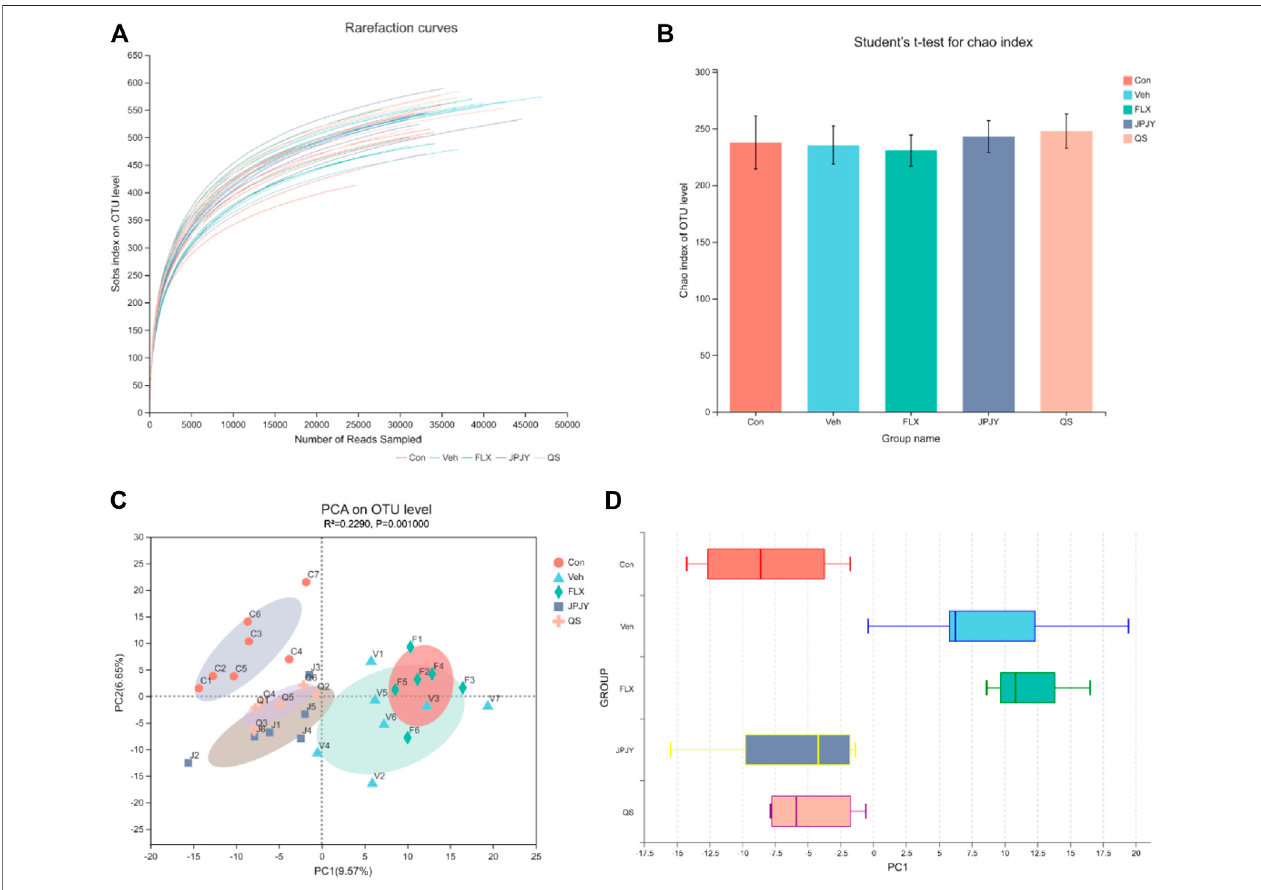
FIGURE 3 | Analysis of gut microbiota following drug treatment. Microbiota composition in feces of mice treated with drugs were analyzed using next generation sequencing. (A) Sobs rarefaction curve. (B) Alpha diversity index (Chao estimator) analysis for each group. (C) PCA (Principal Component Analysis) on OUT level. (D) Plots shown were generated using the PCA. The boxplot in the fi gure represents the discrete distribution of different groups of samples on the PC1 axis.